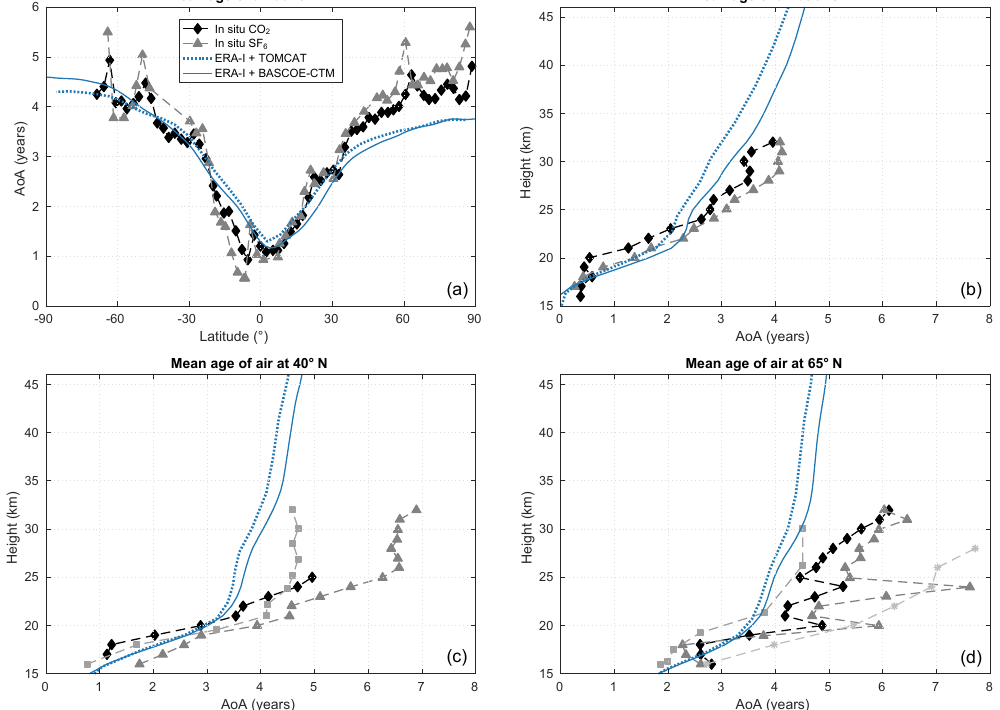
Figure 1. Mean age of air (AoA, in years) from two model simulations using idealized tracers advected by ERA-I for the fixed year 2000. Models shown are BASCOE TM (blue solid lines) and TOMCAT (blue dotted lines). The modeled AoA fields are calculated using as reference the tropical tropopause region (10 ◦ S–10 ◦ N, 100hPa). (a) Values at 20km height; (b) vertical profiles at 5 ◦ S; (c) vertical profiles at 40 ◦ N; (d) vertical profiles at 65 ◦ N. The symbols represent in situ observations collected during the 1990s (see Hall et al., 1999; Waugh and Hall, 2002, for details). The legend in panel (a) applies to all four panels.